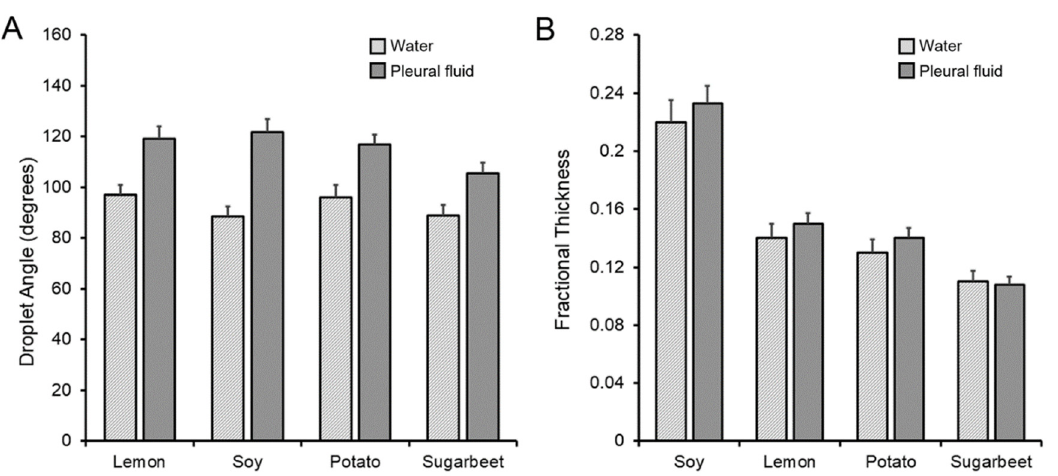
Figure 3. Passive absorption of water and pleural fluid on different plant sources of pectin. Lemon, soy, potato and sugarbeet pectin were compared for droplet contact angle ( A ) and fractional thickness ( B ). The pleural fluid consistently demonstrated larger contact angles than water ( p < 0.01). There was no difference in fractional thickness ( p > 0.05) (error bars = 1